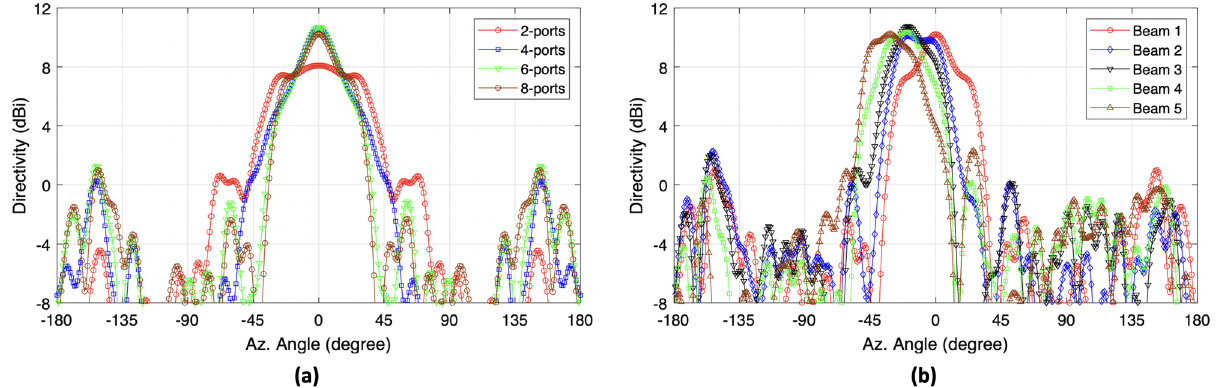
Figure 3. ( a ) Beam shaping achieved when multiple input transceiver ports are excited with same magnitude and phase, ( b ) Beam steering when ideal phase ramp is applied to a shaped